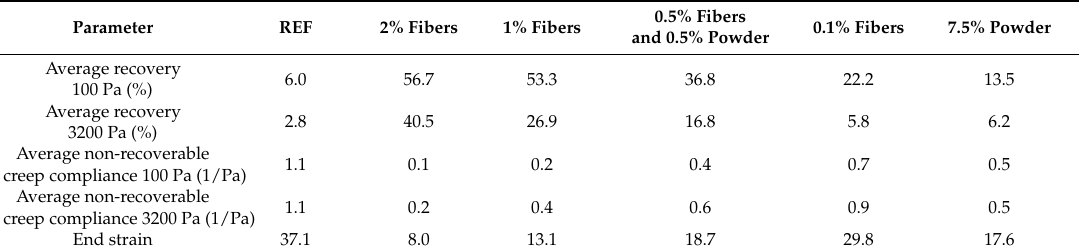
Figure 13. The multiple stress creep and recovery (MSCRT) test results, 50 °C (only repeated creep tests at 3200 Pa are shown). Table 1. The parameters derived from the MSCRT test for various bitumen–peat combinations at 50 °C.